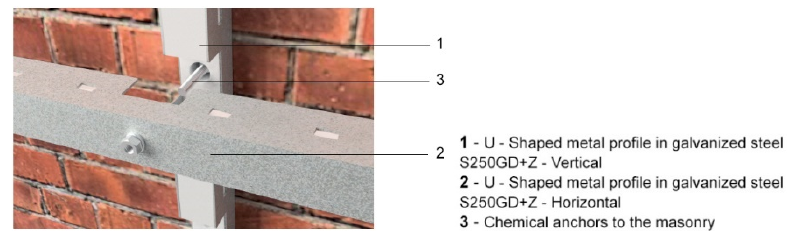
Figure 2. Anchoring system to the masonry structure.